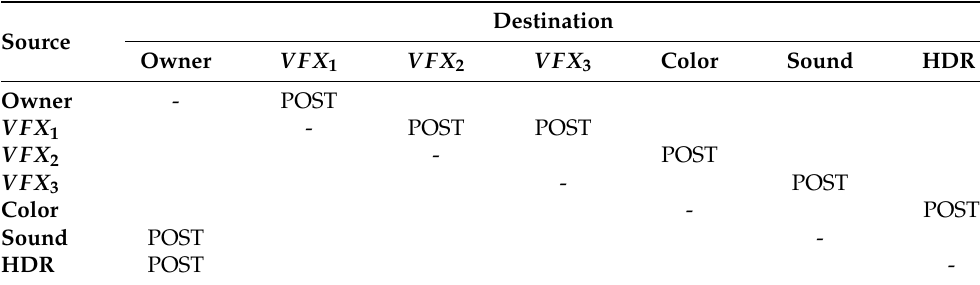
Table 1. Proof of Concept